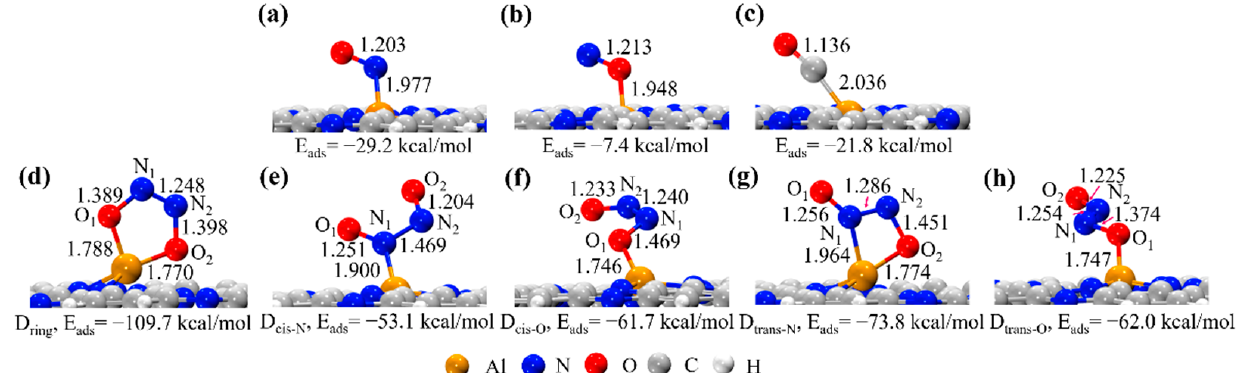
Figure 2. Optimized adsorption configurations for the ( a ) NO (N-end), ( b ) NO (O-end), ( c ) CO, ( d ) ring-(NO) 2 dimers, ( e ) cis-(NO) 2 dimers (N-end), ( f ) cis-(NO) 2 dimers (O-end), ( g ) trans-(NO) 2 dimers (N-end), and ( h ) trans-(NO) 2 dimers (O-end) on Al-C 2 N surface. All bond lengths are in Å. Table 1. Calculated adsorption energies (E ads , kcal/mol), adsorption free energies ( ∆ G, kcal/mol), and net charge-transfer values (q, e) for different adsorption species on the Al-C 2 N surface, along with the corresponding energy barriers (E a , kcal/mol) and reaction energies ( ∆ E r ) for a single NO or (NO) 2 dimer reduction on Al-C 2 N surface.